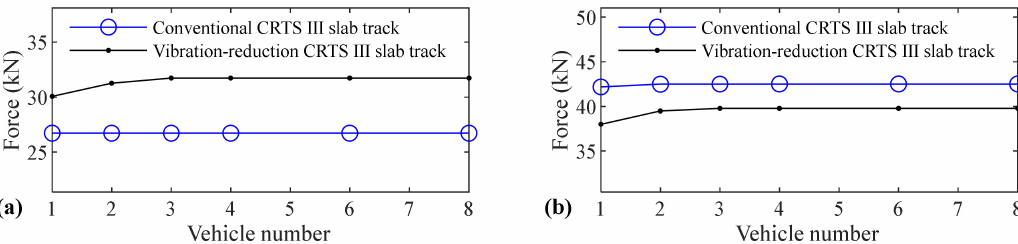
Figure 10. Relation between vehicle number and negative bending moment of rail: (a) without and (b) with random track irregularity.